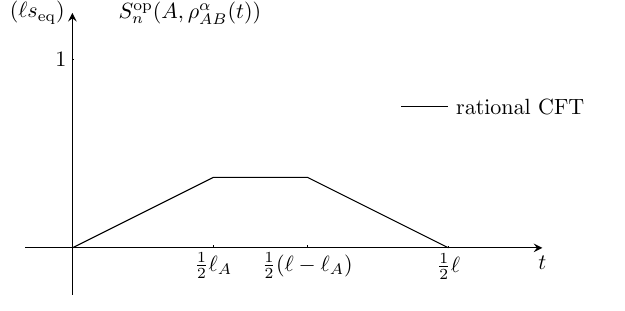
Figure 5 . The \fusion channels" of the 6-point chiral correlation functions. (a) t ‘ A = 2 < t < ‘ B = 2, (c) ‘ B = 2 < t < ‘= 2, (d) ‘= 2 < t .